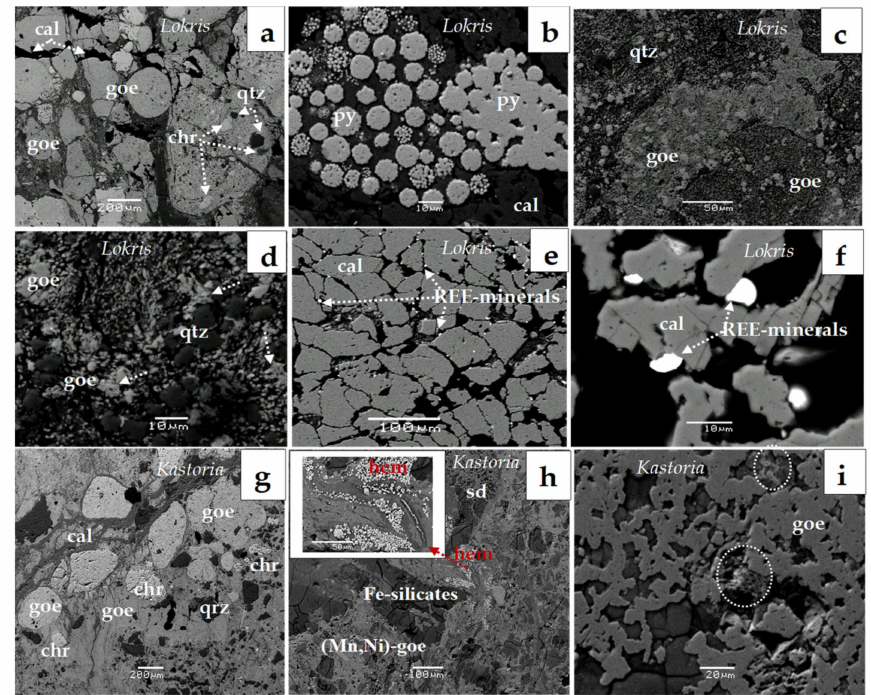
Figure 3. Selected back scattered electron (BSE) images from the Lokris and Kastoria laterites. A general overview from Lokris ( a ); the transitional zone between ore and overlying limestone showing neoformed clusters of framboidal pyrite with fine crystals at the contour of early framboidal pyrite ( b ); isolated and aggregates of bacteriomorphic goethite (goe) associated with quartz (qtz) ( c , d ) and REE-minerals ( e , f ) from the contact of the lowest part of the Nissi–Patitira deposit with the carbonate basement. Similarly, from the Kastoria Fe–Ni laterites showing different morphologies: Rounded fragments of goethite in a matrix of (Mn,Ni)-goethite with goethite fragments of an earlier stage, detrital quartz, and chromite ( g ); close-up view of morphology of fine-grained hematite crosscutting earlier mineral phases ( h ); Mn-bearing siderite cutting all previous phases ( h ) and neo–formed goethite growing over microorganism cells ( i ). Abbreviations: goe = goethite; chr = chromite; py = pyrite; qtz = quartz; cal = calcite; sd = siderite; hem = hematite; REE = Rare Earth